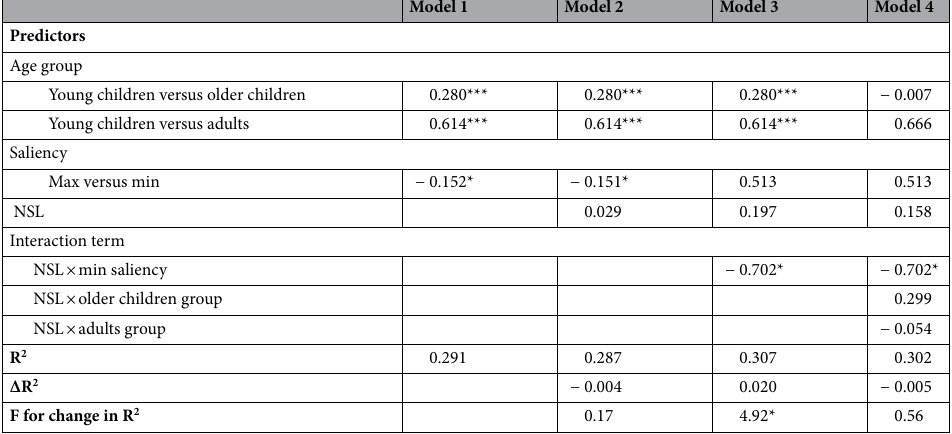
Table 1. Summary of hierarchical regression analyses for variables predicting ‘Correct’ responses. Standardized regression coefficients (β) are reported for each predictor. The age group was presented as three dummy variables (young children, older children, and adults) with young children serving as the reference group. The saliency condition was presented as two dummy variables (Max and Min) with Max saliency serving as reference condition. * p < .05, ** p < .01, *** p <